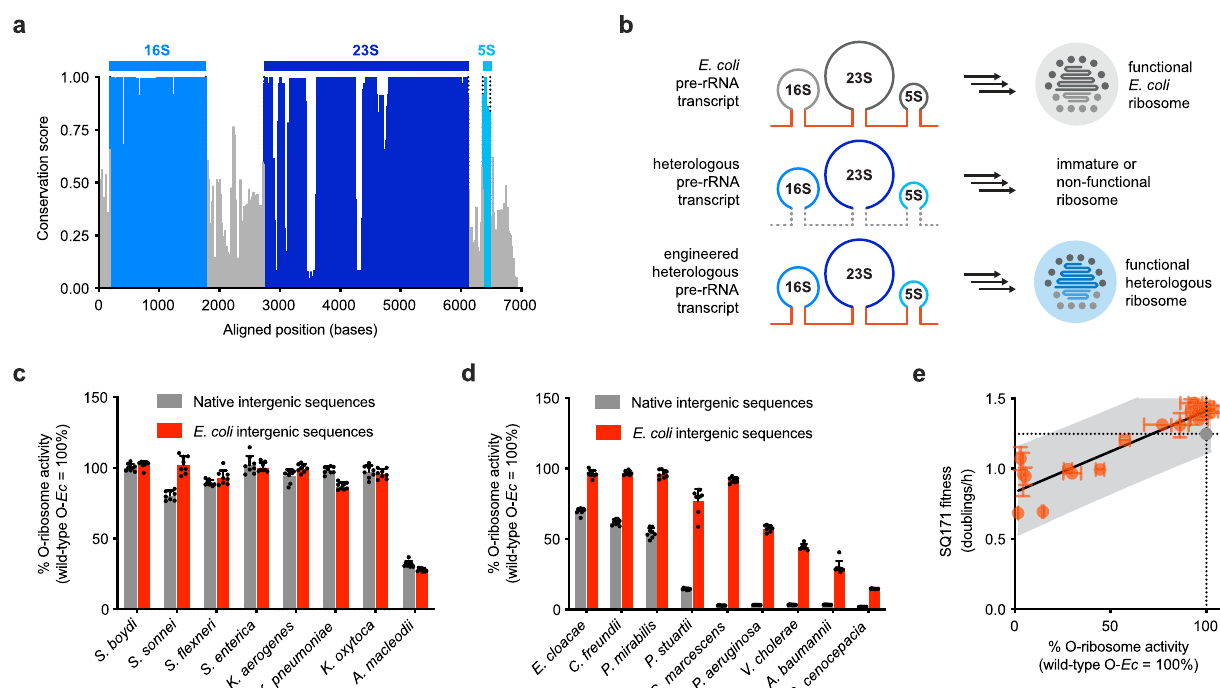
Fig. 3 Evaluating the effects of O-rRNA intergenic sequence replacement on heterologous translation. a Per-base sequence conservation 41 across 34 evaluated rRNA operons, showing limited conservation in intergenic regions as compared to structural rRNA genes. b Schematic representation of the intergenic sequence replacement strategy. c Effects of intergenic sequence replacement on O-rRNAs with high 16S rRNA sequence identity to E. coli (96.2 – 99.6%), as well as A. macleodii (85.9%), illustrating a minimal effect on orthogonal translation ( n = 8). d Effects of intergenic sequence replacement on O-rRNAs with intermediate 16S rRNA sequence identity to E. coli (81.5 – 97.4%), illustrating a substantial effect on intergenic sequence replacement ( n = 8). e Correlation between activity in the O-translation circuit and fi tness in SQ171 strain complementation assays for 21 rRNAs evaluated after intergenic sequence replacement, showing a linear relationship. E. coli rRNA control plotted as a gray circle (99% CI, R 2 = 0.84). Data re fl ect the mean and standard deviation of 3 – 8 biological replicates. Comprehensive SQ171 complementation and O-translation data (including precise number of replicates) reported in Supplementary Table 1. Wild-type O- Ec wild-type orthogonal E. coli rRNA, O-ribosome orthogonal ribosome, h hour. Source data are available in the Source Data